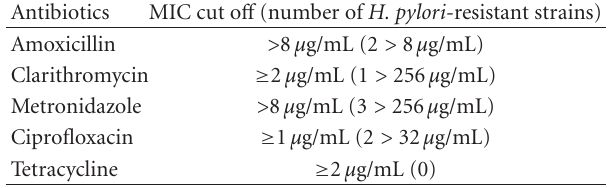
Table 2: Prevalence of antibiotic resistance of H. pylori isolates after treatment with omeprazole/esomeprazole, clarithromycin, and amoxicillin or omeprazole/esomeprazole, clarithromycin, and